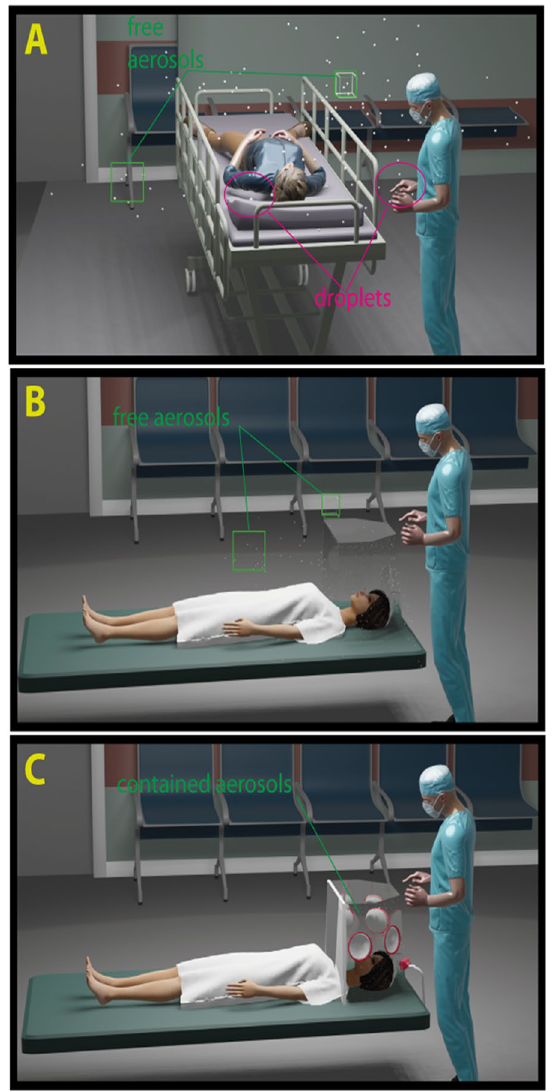
Figure 1. Proposed routes of transmission of COVID-19 and methods of containment. ( a ) Spreading of respiratory infected disease as suspected in a COVID-19 patient is by direct and indirect droplet contact (magenta ovals), and airborne via aerosol particles (green squares). ( b ) A regular intubation shield can stop the majority of large droplets. However, it is unable to contain aerosol particles (green squares) due to open design. ( c ) The BADGER with all accessories assembled and suction turned on, can act as both a shield and a containment chamber, trapping aerosol particles inside until they are suctioned